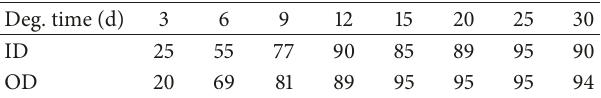
Table 3: Degradation (%) of ID and OD films (results based on average) by